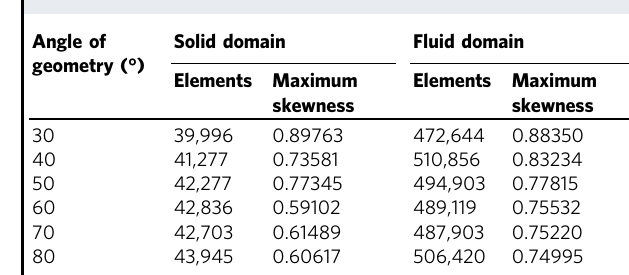
Table 1 Mesh properties: element count and maximum skewness for each